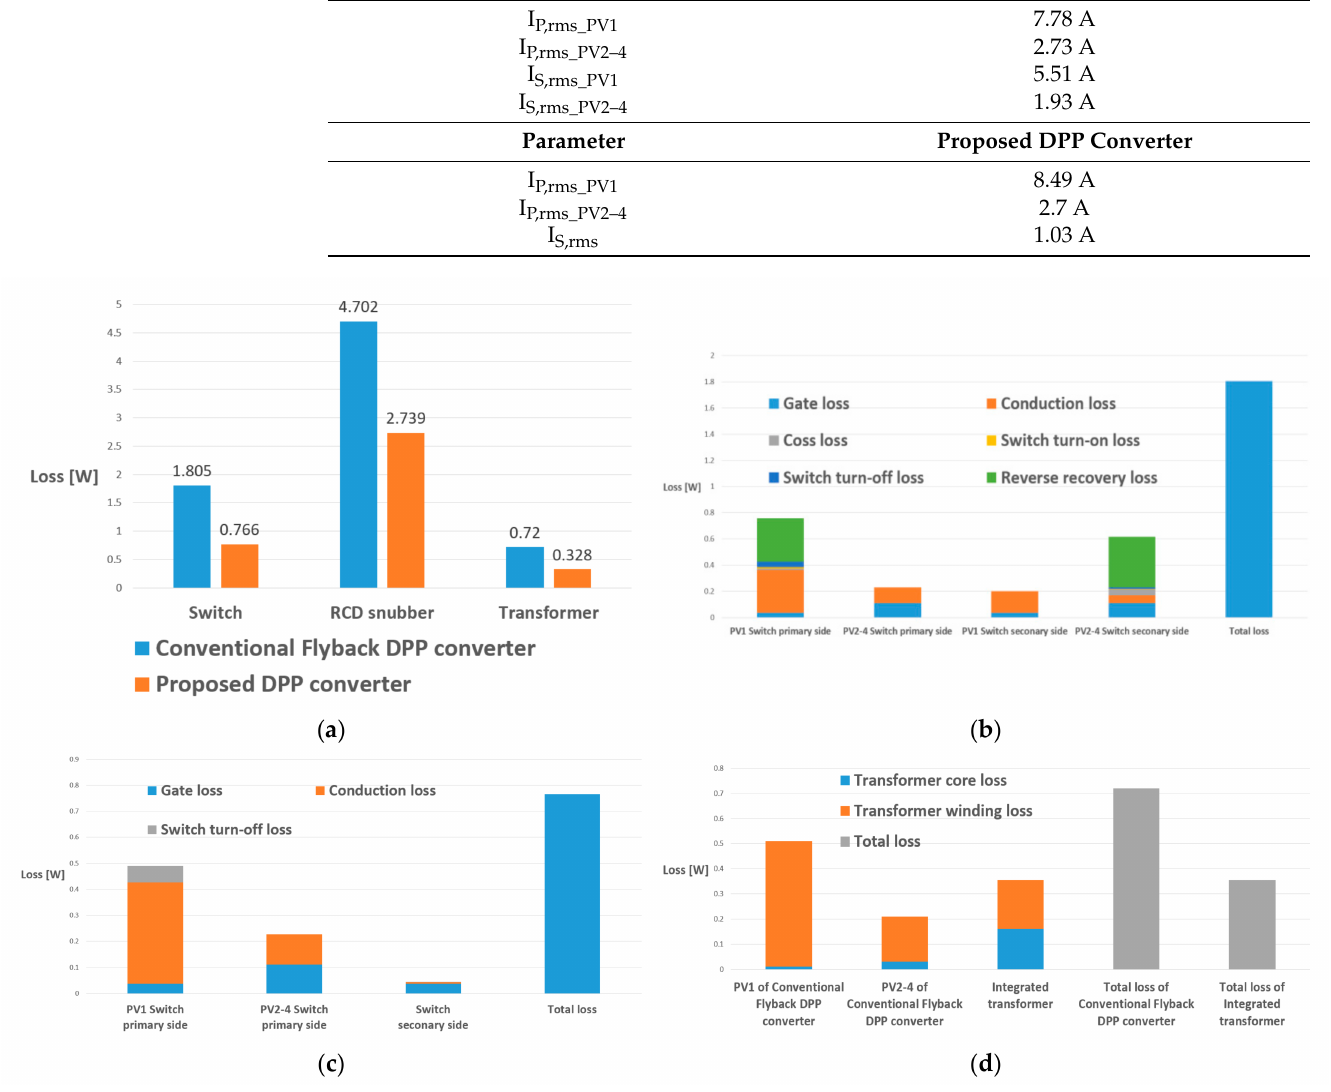
Figure 6. Loss analysis and comparison. ( a ) Switch, RCD snubber and transformer. ( b ) Conventional flyback DPP converter. ( c ) Proposed DPP converter. ( d )